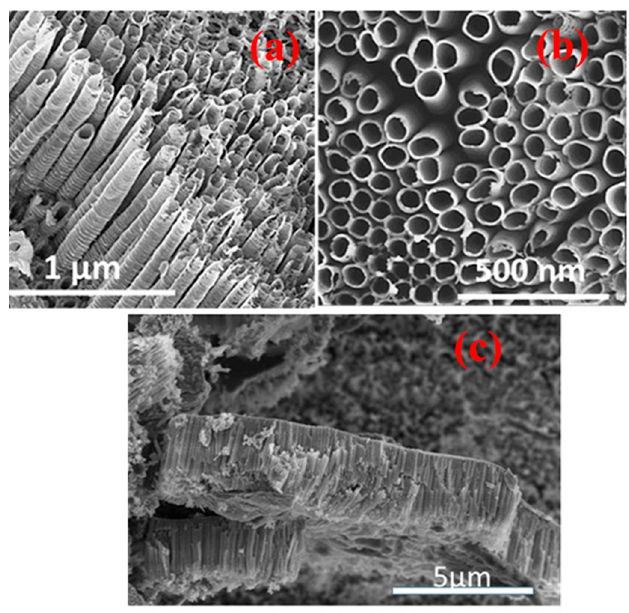
Figure 1. SEM micrographs of highly organized, vertically oriented TiO 2 nanotubular array: ( a ) side wall view; ( b ) top view; and ( c ) an island chunk of TNA lying on the mouth of the nanotubes.